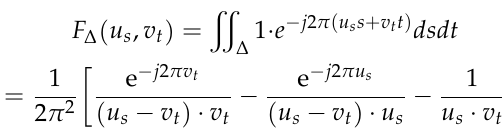
Figure 11. Results of optical reconstruction: ( a ) bunny and ( b ) Alex.